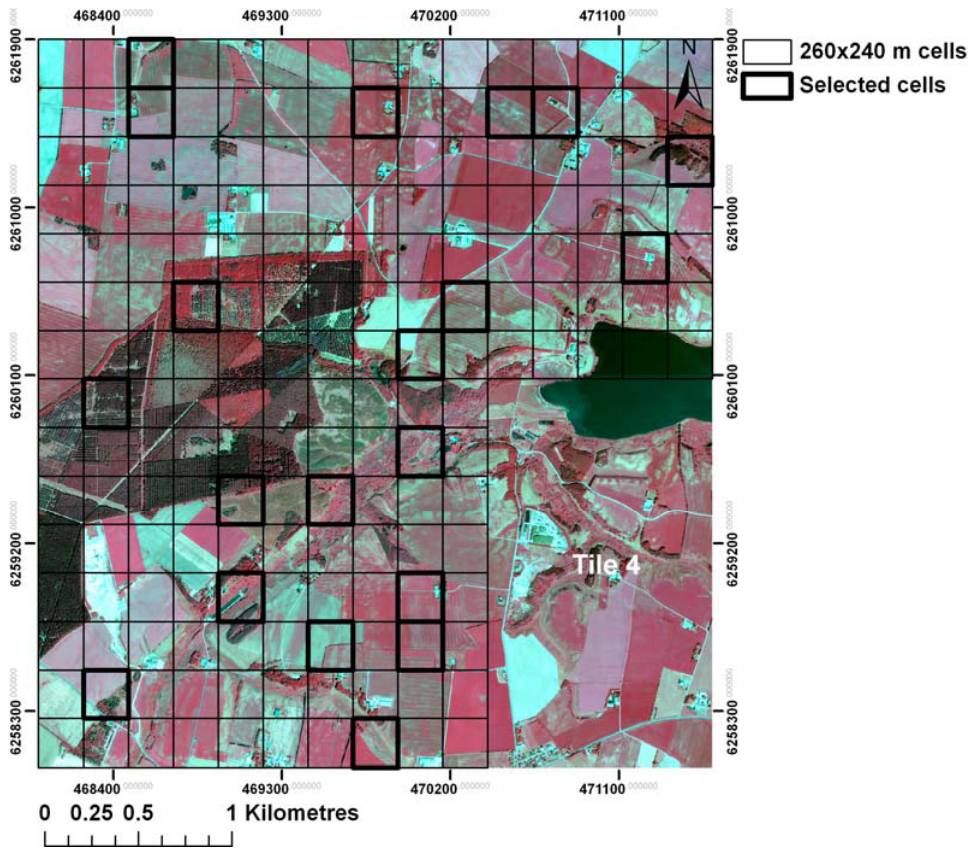
Figure 8. The grid consisting of 260 × 240 m cells of which 20 were selected randomly for reference data sampling. Tile 4 is used for training and is therefore not